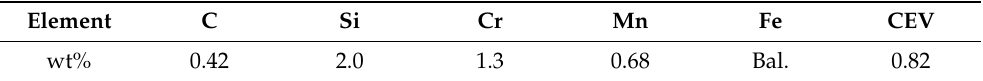
Table 1. Chemical composition and CEV of 42SiCr steel used in this work. Element C Si Cr Mn Fe CEV wt% 0.42 2.0 1.3